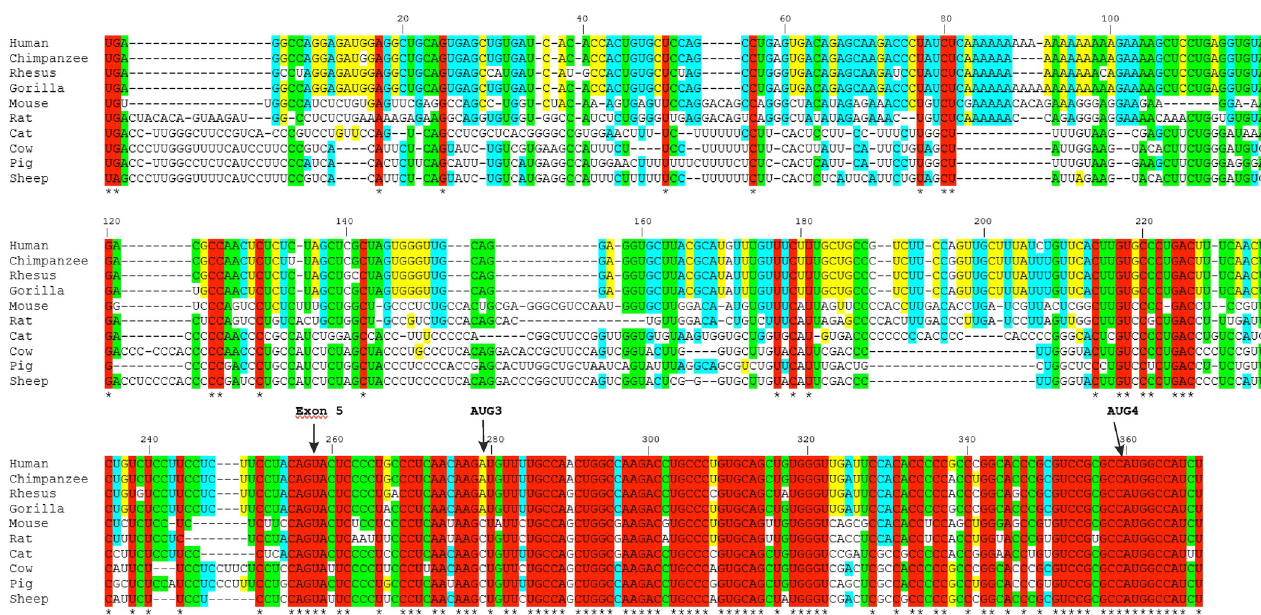
Fig 2. Sequence conservation of the 5 0 -terminal region of Δ 133p53 mRNA. Comparison of the 5 0 -terminal regions of Δ 133p53 mRNA sequences derived from ten different species. The gene sequences were obtained from Ensembl Website. Translation initiation codons AUG3 and AUG4 as well as the exon 5 site are indicated by arrows. The alignment was performed using Clustal Omega program. Alignment is colored according to the percentage of sequence conservation (red: 100%; green: 80%– 99%; blue: 60%– 79%; yellow: 59% - 40%; black: 39%-0).